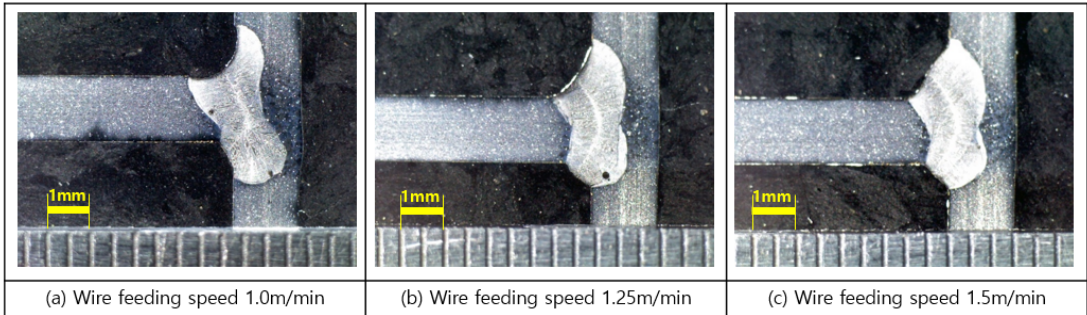
ff erent wire feeding speeds with 1.75 kW of laser power. Metals 2020 , 10 , x FOR PEER REVIEW